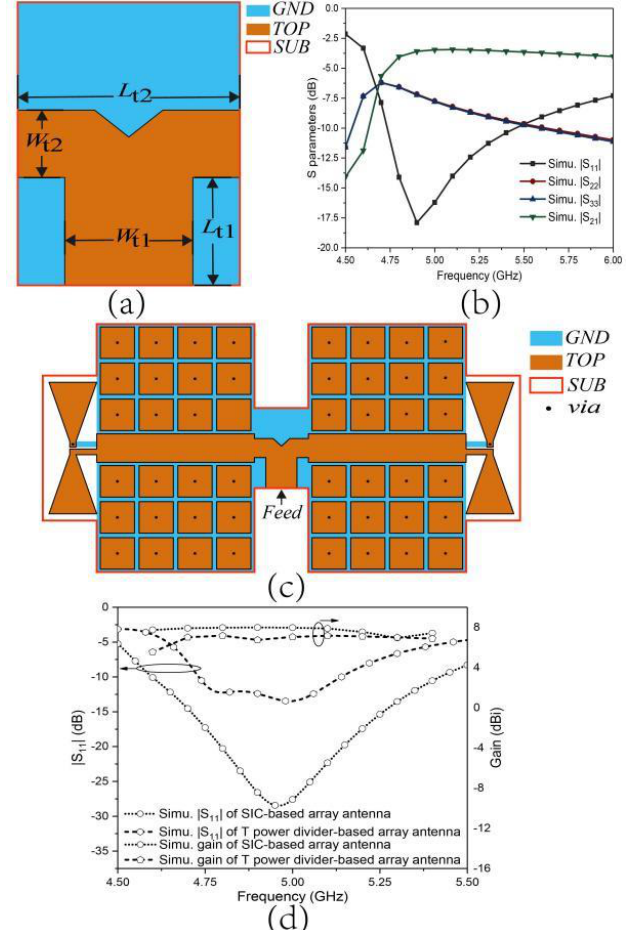
Figure 13. ( a ) Geometry of T-shape power divider. ( b ) Simulated results of T-shape power divider. ( c ) Geometry of T-shape power divider-based array antenna. ( d ) Comparison results of SIC-based and T-shaped power divider-based array antennas.